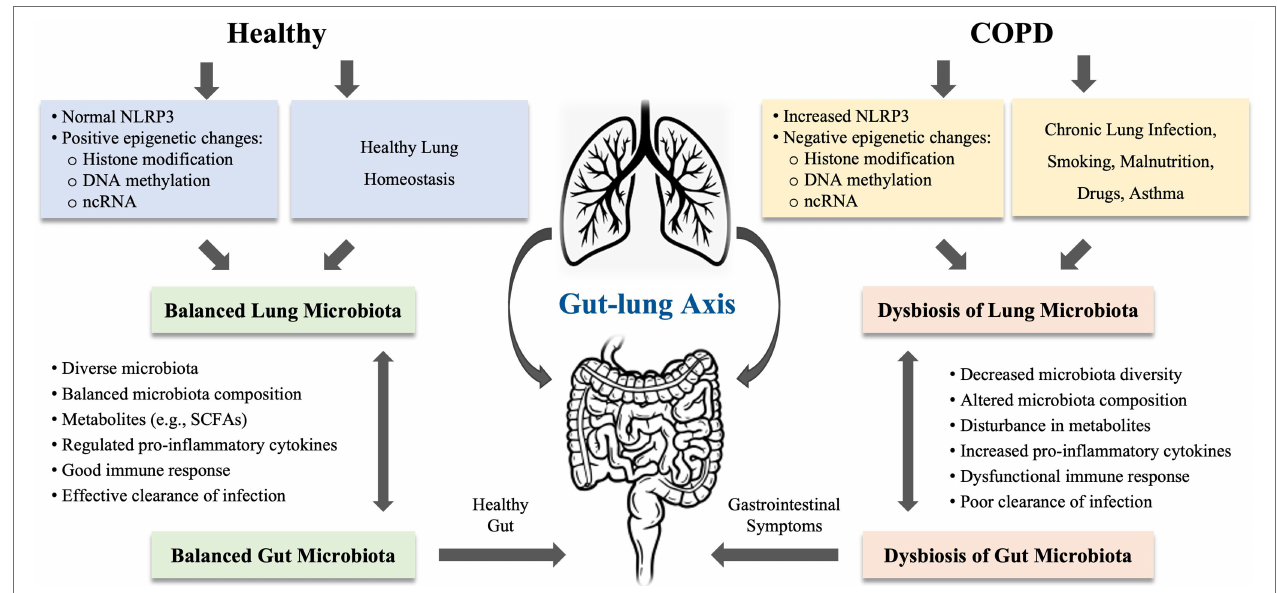
FIGURE 1 | The proposed mechanisms of gut-lung axis involved in chronic obstructive pulmonary disease (COPD). The gut-lung axis concept postulated that disturbance in gut microbiota may have a profound effect on lung disease. The microbiota in gut and lung is closely linked to each other. The microbiota in both organs can be influenced by chronic lung infections, smoking, malnutrition, drugs, and asthma. COPD is highly associated with the dysbiosis in the gut and lung, which can be induced by epigenetic changes or regulated via NLRP3 inflammasome. In COPD, disturbance in gut-lung axis leads to decreased microbiota diversity, altered microbiota composition, disturbance in metabolites, increased production of proinflammatory cytokines, and dysfunctional immune response, resulting in poor clearance of infection in the lung or gastrointestinal symptoms or diseases. NLRP3, nucleotide-binding oligomerization domain (NOD)-like receptor (NLR) family, pyrin domain-containing protein; ncRNA, non-coding RNA; and SCFAs, short-chain fatty